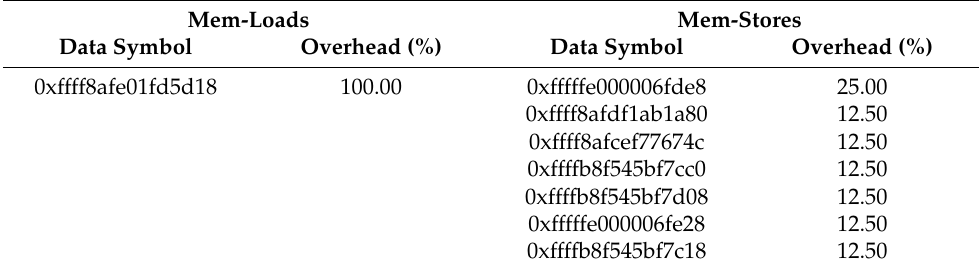
Table 4. Legit AES encryption program detection results.